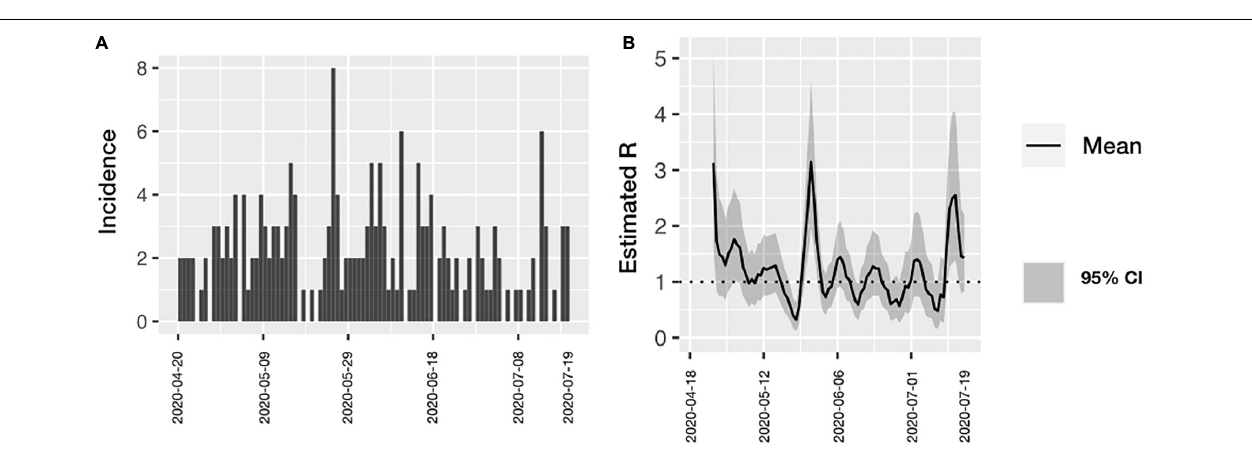
FIGURE 2 | (A) Incidence of COVID-19 among all health personnel according with time of symptoms onset. (B) Estimated Rt over time in all health personnel. The effective transmission rate was calculated in all the hospital workers. Confidence Intervals are